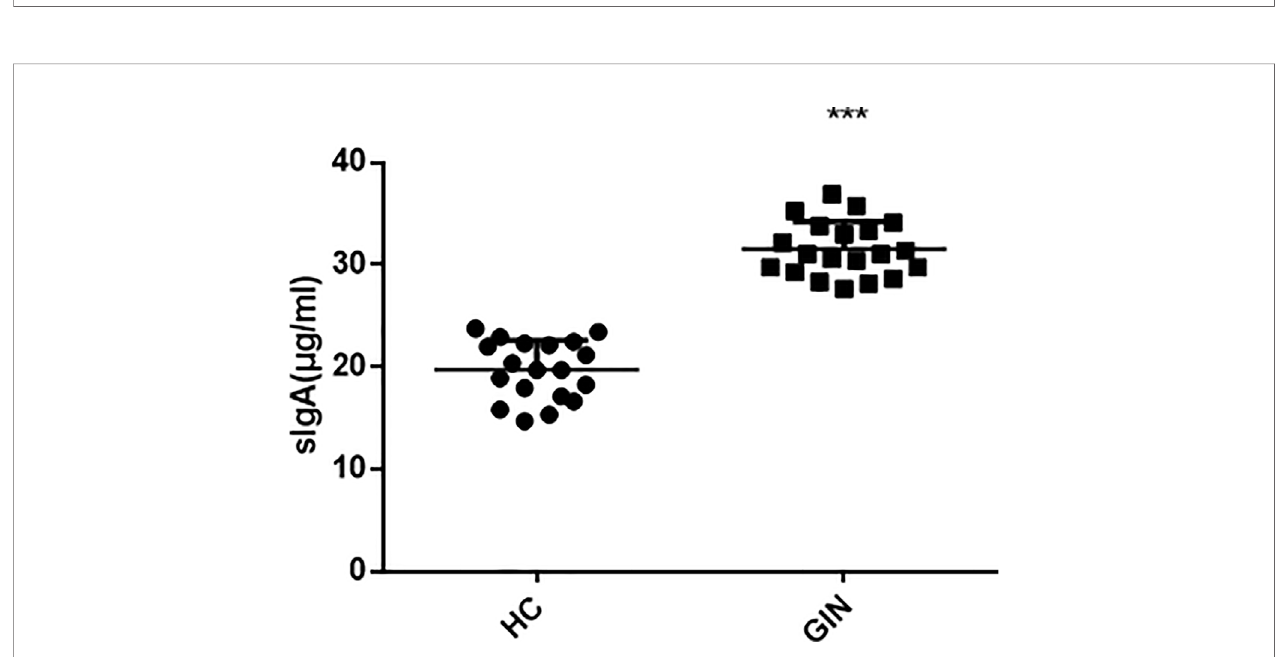
FIGURE 5 | Levels of SIgA in patients ’ saliva. *** P < 0.001 versus healthy